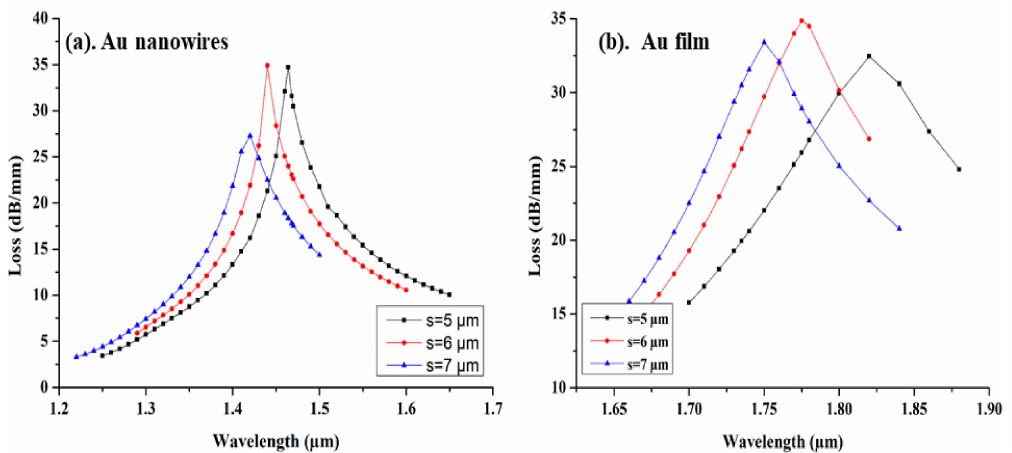
Figure 6. Loss spectra with the variation of channel size for ( a ) AuNWs and ( b ) Au film.